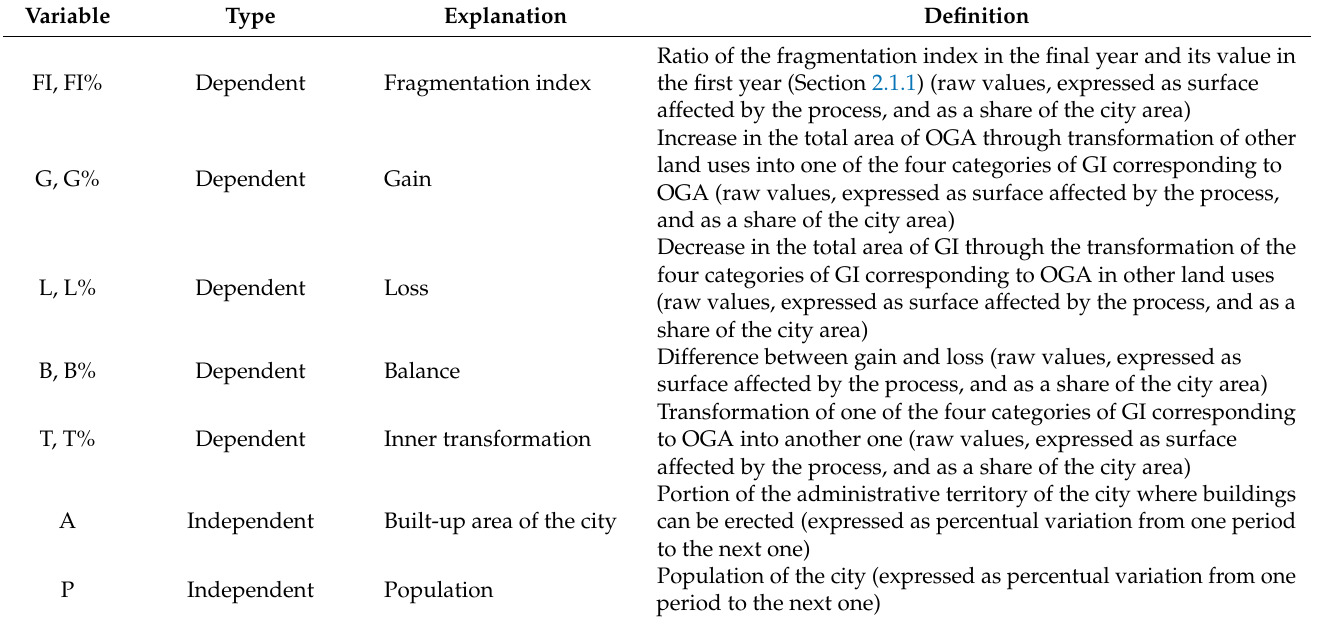
Table 3. Variables included in the study and their